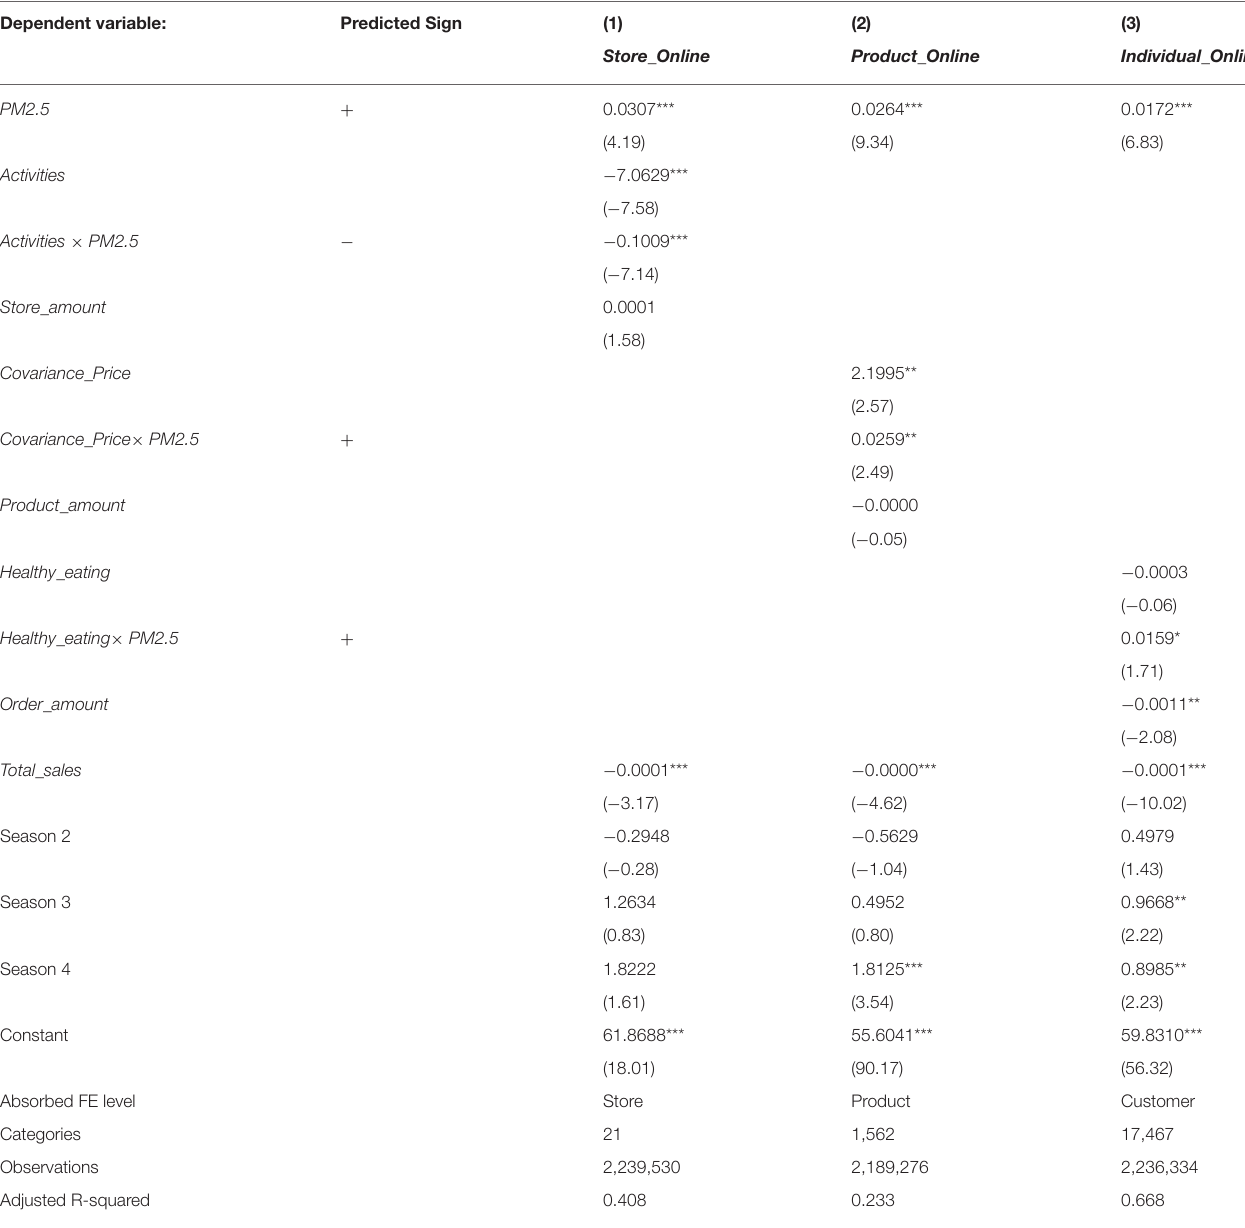
TABLE 7 | Interaction effect regression